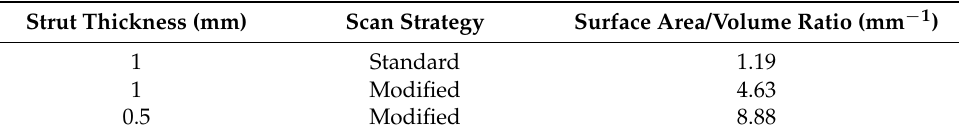
Table 2. Surface-to-volume ratio estimated by µ-CT.